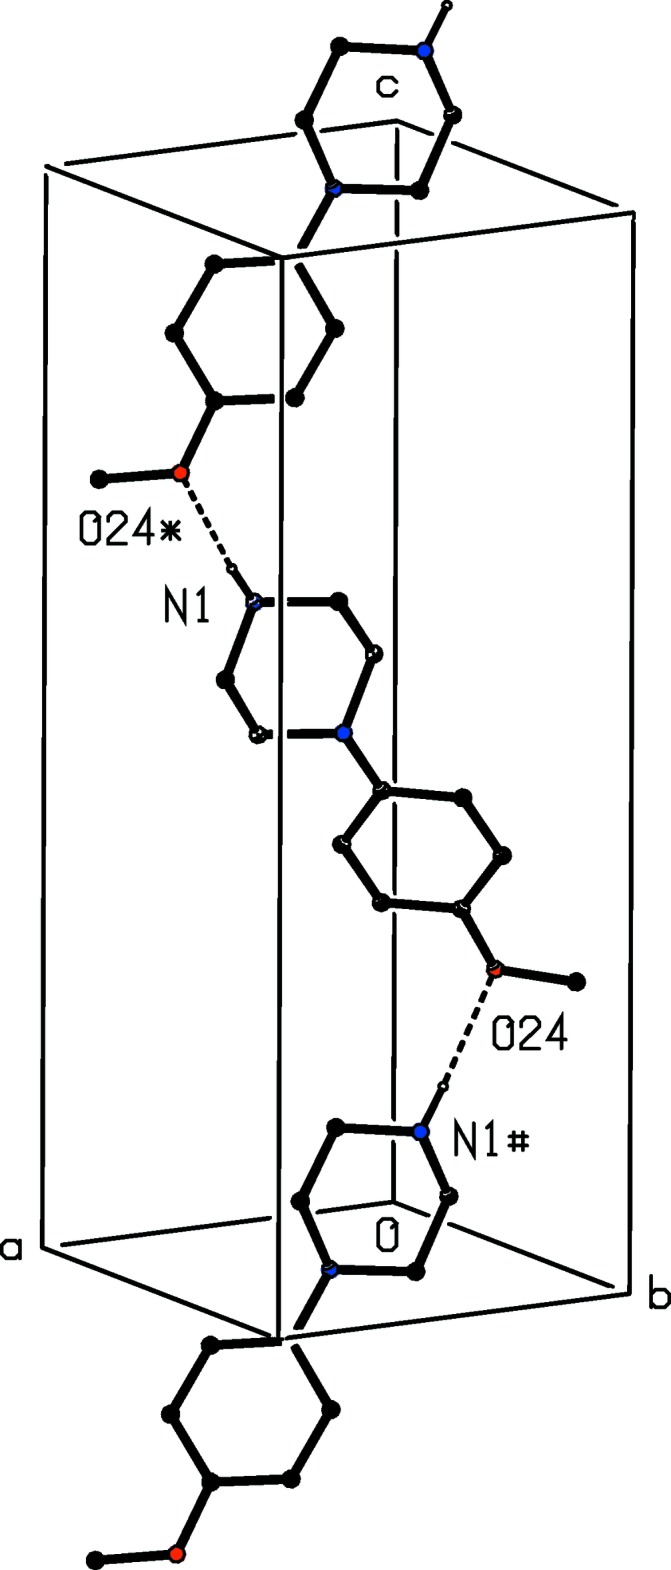
Part of the crystal structure of compound (I) showing the formation of a hydrogen-bonded chain parallel to [001]. Hydrogen bonds are drawn as dashed lines and, for the sake of clarity, the H atoms bonded to C atoms have been omitted. The atoms marked with an asterisk (*) or a hash (#) are at the symmetry positions (1 − x, 1 − y,  + z) and (1 − x, 1 − y, − + z), respectively.